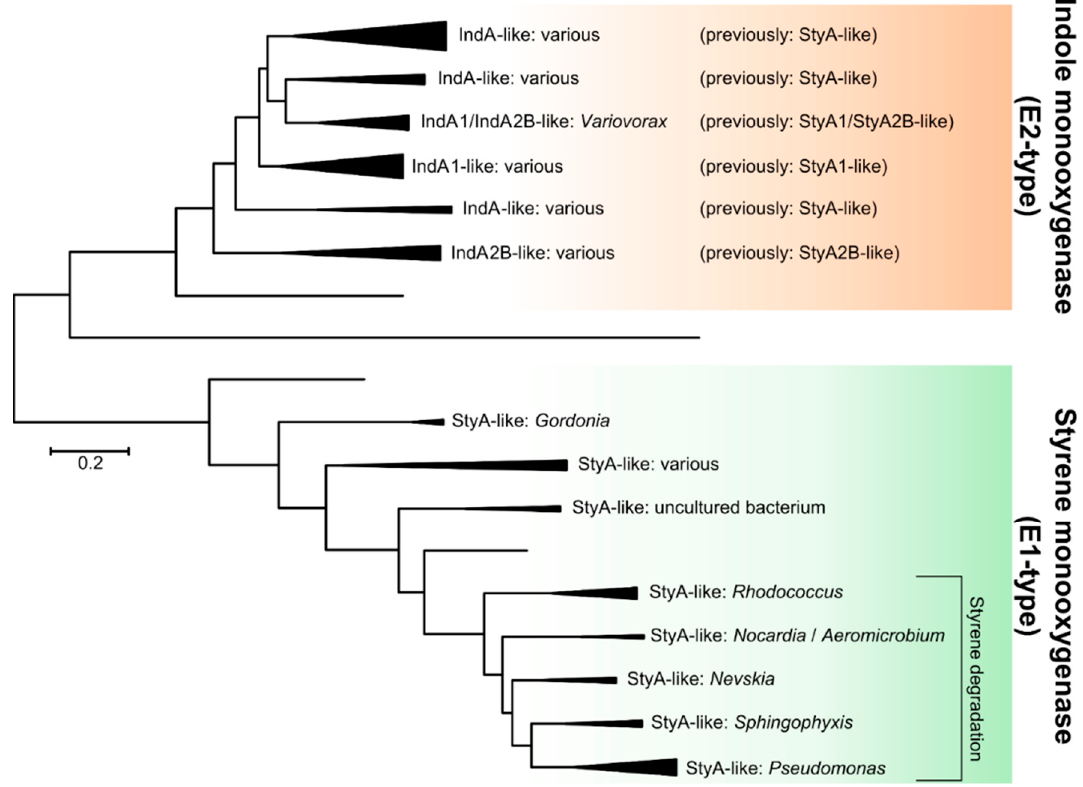
Figure 6. Condensed phylogenetic distance tree of group E monooxygenases. Group E enzymes cluster in two different types (E1 and E2). Styrene monooxygenases (SMOs) that are edged by a bracket are proven or likely involved in styrene degradation, as the strains harbor cognate gene clusters [118–122]. Amino acid sequences were aligned by using the ClustalW algorithm and after phylogenetic analysis, the maximum likelihood tree was constructed applying the MEGA7 software with bootstraps of 1000 replicates [50]. Fusion proteins were truncated for the reductase part.